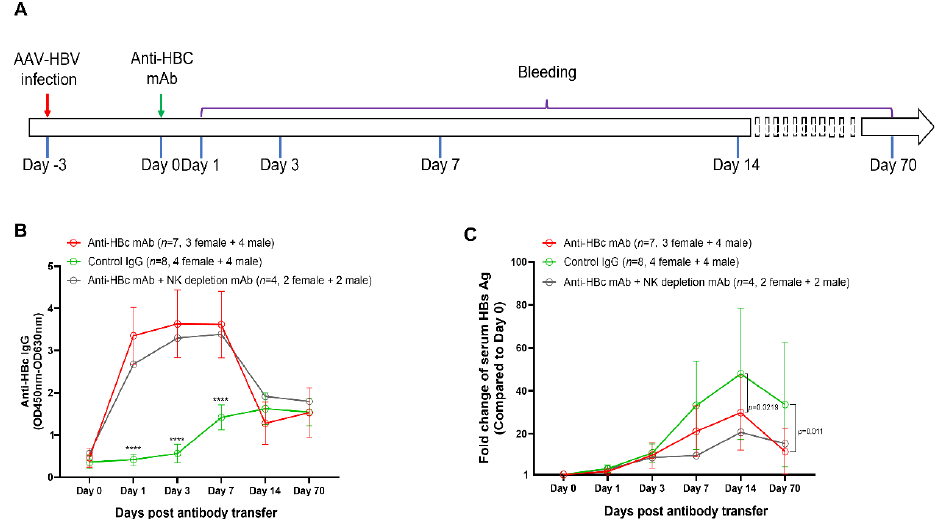
Figure 9. Treatment with an anti-HBc mAb suppressed the increase of serum HBsAg in AAV8-1.3HBV infected mice. ( A ) the design of the antibody transfer experiment. 5 × 10 10 GC of AAV8-HBV1.3 was given to each mouse via tail vein injection. Three days later, seven mice (3 female, 4 male) were injected intraperitoneally with an anti-HBc monoclonal antibody (100 µ g/mouse). Eight mice (4 female, 4